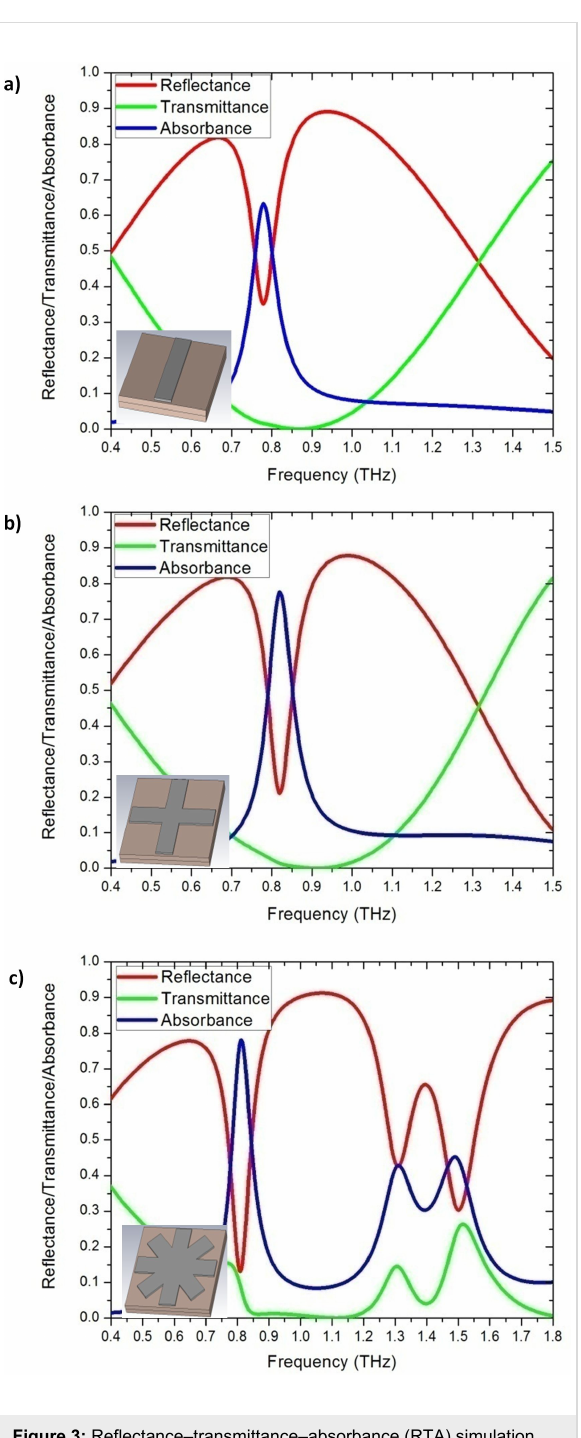
Figure 3: Reflectance–transmittance–absorbance (RTA) simulation results: a) Cut-wire sandwich structure, b) cross-shaped sandwich structure, and c) star-shaped sandwich structure.